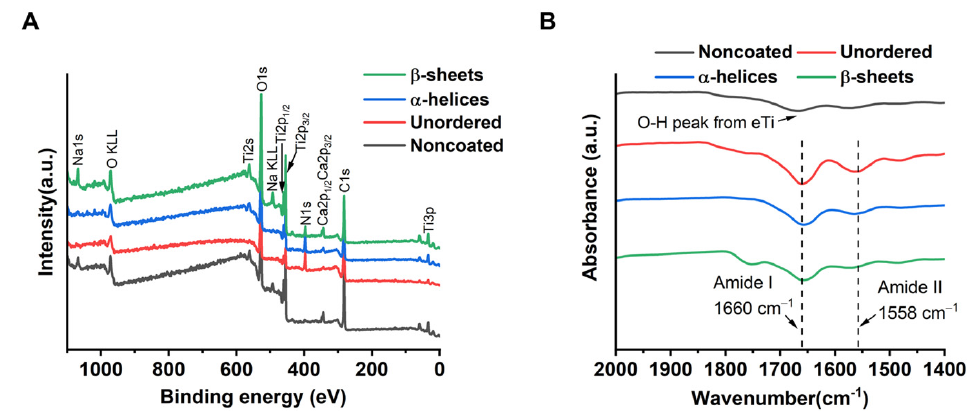
Figure 3. ( A ) XPS and ( B ) FTIR spectra of noncoated Ti or Ti coated with GL13K as unordered peptides, self-assembled α -helices, or self-assembled β -sheets.